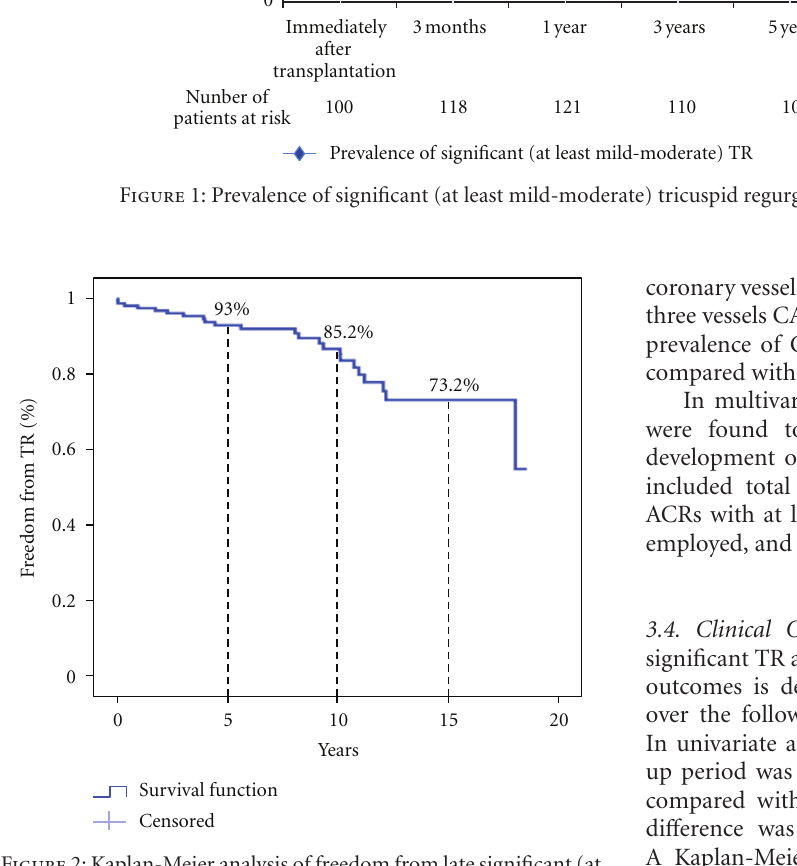
Figure 2: Kaplan-Meier analysis of freedom from late significant (at least mild-moderate) tricuspid regurgitation